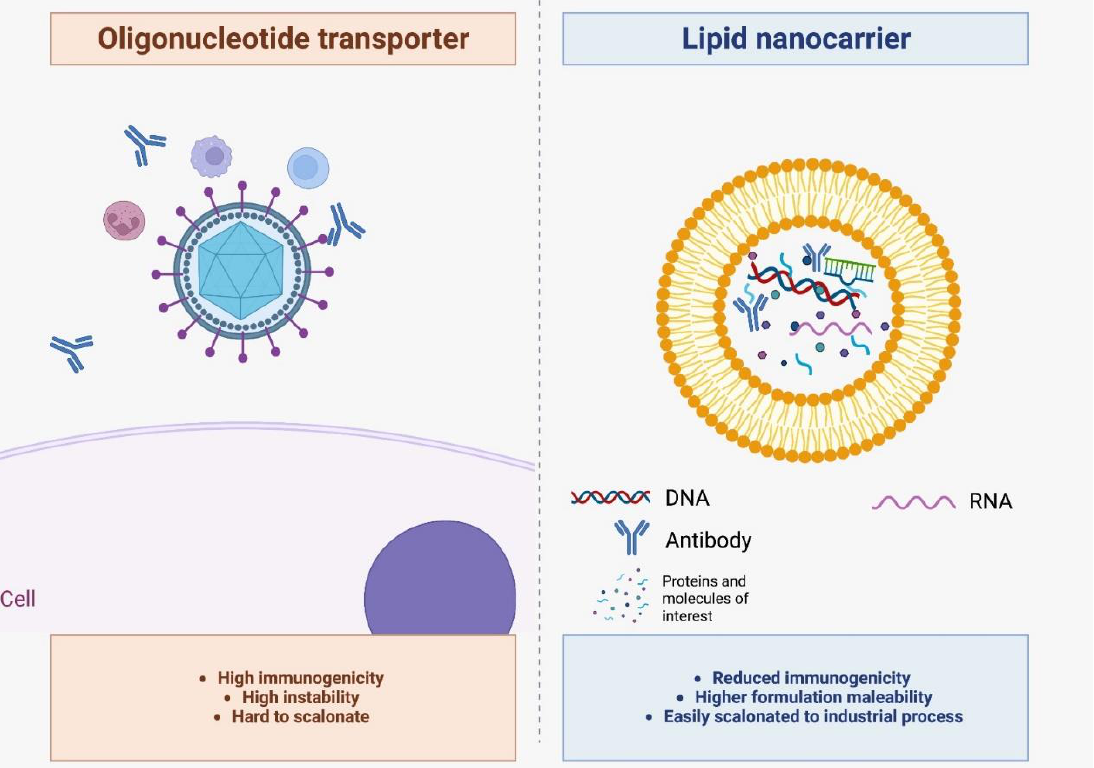
Figure 2. Different types of nucleic acid transporters. In comparison to liposomes, viral vectors are more immunogenic due to the presence of viral molecules that can be recognized by our immune system. On the other hand, liposomes, prepared with phospholipids, are well tolerated by immune cells. Moreover, the surface of the liposomes can be decorated with target molecules, such as antibodies or other biomolecule motifs, to deliver the vesicles to specific tissue sites.